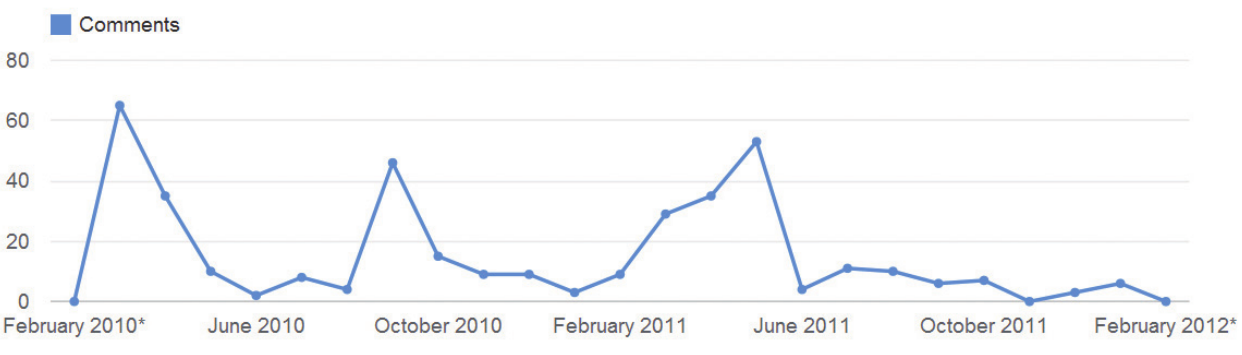
Figure 5. Number of monthly comments on the INGV YouTube channel from the opening* to date*. The peaks generally coincide with the publication of videos on relevant events. The first peak followed the publication of a video on the L’Aquila earthquake, with a reconstruction of its presumed